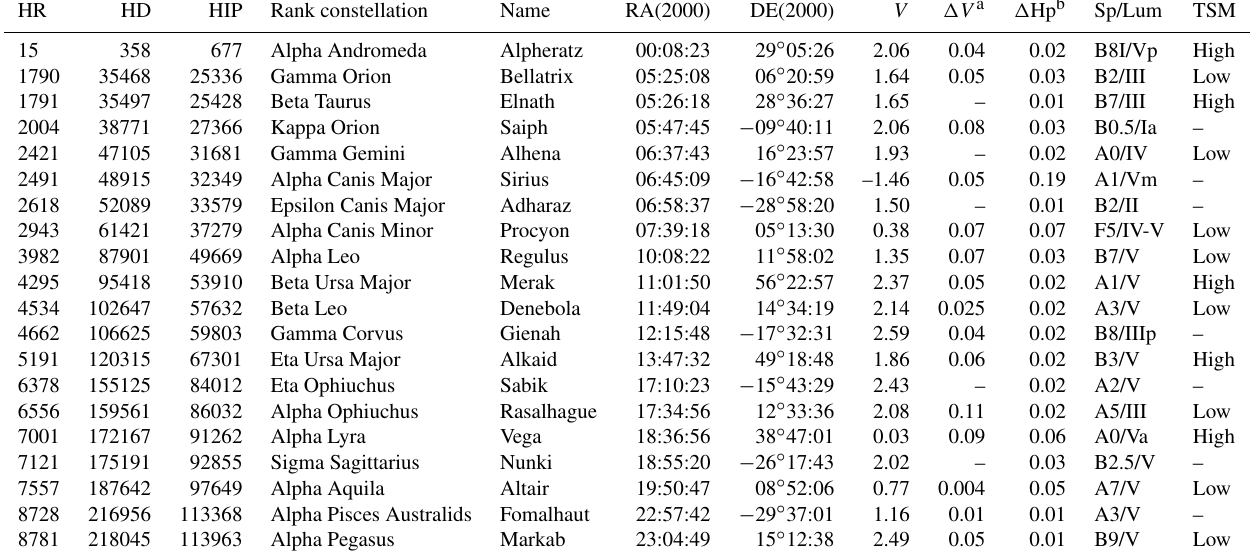
Table B1. Star selection from the Northern Hemisphere bright stars. These stars are usually referred to by their Harvard Revised (HR) Bright Star photometry catalogue (Pickering, 1908). Their HD (Henry Draper catalogue; Cannon and Pickering, 1918) and HIP (Hipparcos catalogue; van Leeuwen et al., 1997) codes are also listed in order to facilitate their identification. The subsequent columns show their affiliated rank (Greek letter) and constellation, common name, right ascension (RA), declination (DE) coordinates at epoch 2000, and visual magnitude ( V ). GCVS and Hipparcos peak-to-peak magnitude variations ( (cid:49)V and (cid:49) Hp, respectively) are indicators of star stability. The next column shows the spectral class (Sp) of the star (including its 0–9 numerical subclass) and its luminosity class (Lum). The last column is specific to the Arctic; it indicates the TSM role of each Arctic star (“high” or “low”), as described in Sect. 3.4.2.